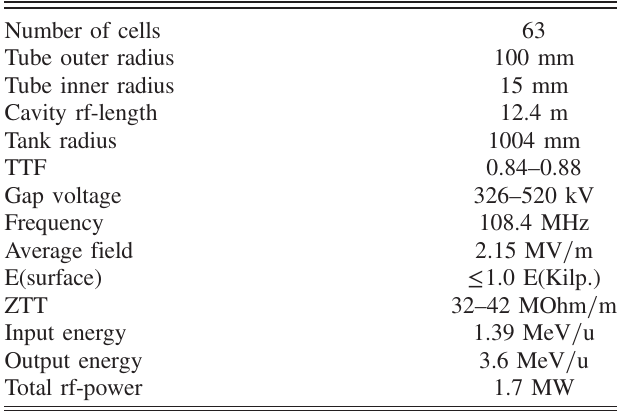
TABLE I. Main parameters of the first post-stripper DTL cavity of the